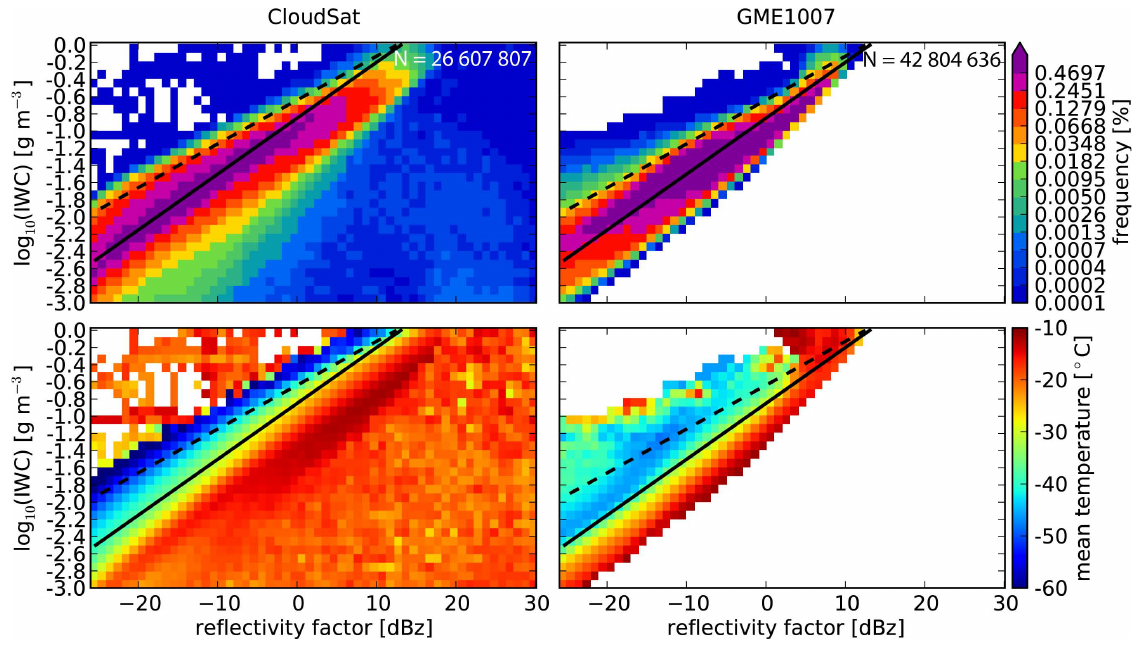
Fig. 2. Z-IWC relation for CloudSat (left) and GME1007 (right) for 1 July 2009 to 31 October 2009. Top row: frequency distribution; bottom row: mean bin-temperatures. Frequency distributions normalized with number N of included pixels. Black lines: Z-IWC relation from Hogan et al. (2006) for T =− 20 ◦ C (solid) and T =− 50 ◦ C